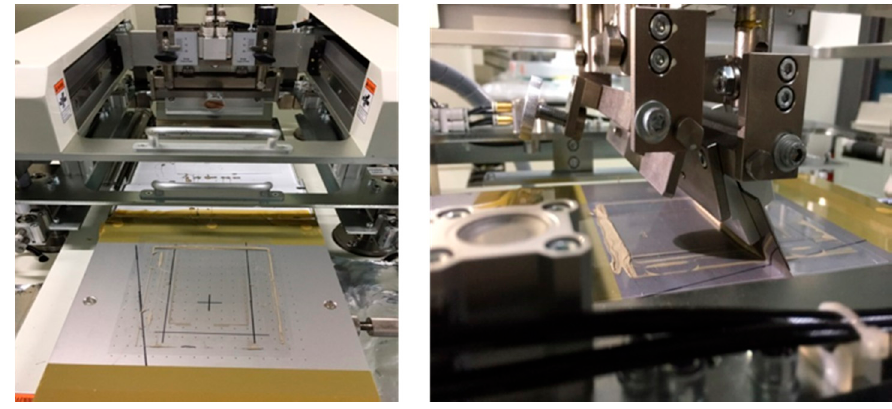
Figure 3. Filling process of Ag/Cu@Ag nanoparticle paste with doctoring machine. Table 1. Formulation of photosensitive UV resin for imprinting process to make trench layers.